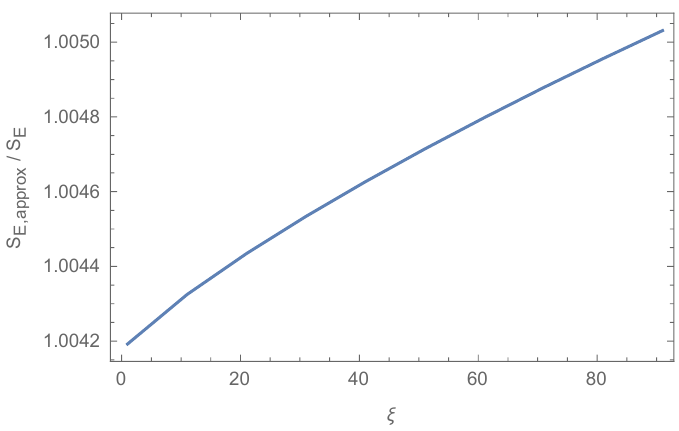
Figure 4. The estimate of the tunneling action by calculating the integral in eq. (3.11 )using the quartic approximation in eq. (3.12). We normalize φ to the action computed using Findbounce. The black dot represents the minimum of the integral in eq. (5.1).